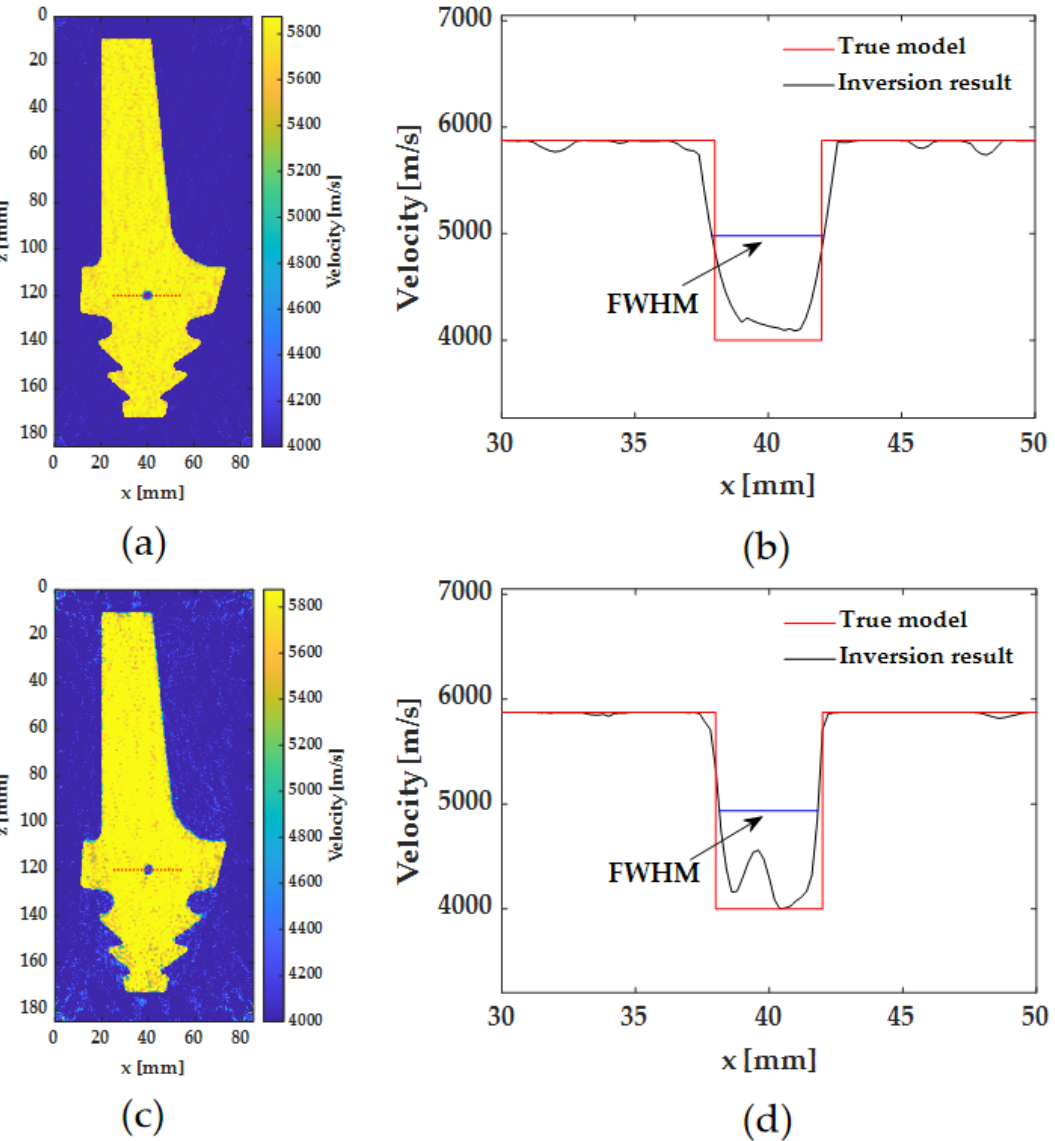
Figure 16. Inversion results with an inaccurate initial model. ( a ) Tomograph and ( b ) horizontal profile for an initial model with a − 2% error. ( c ) Tomograph and ( d ) horizontal profile for an initial model with a +2% error.